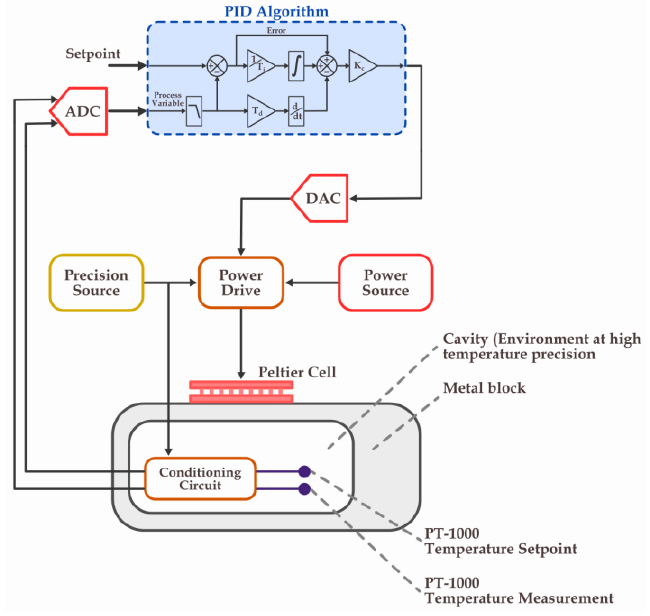
Figure 1. Diagram of the system used to achieve temperatures with high accuracy and precision.